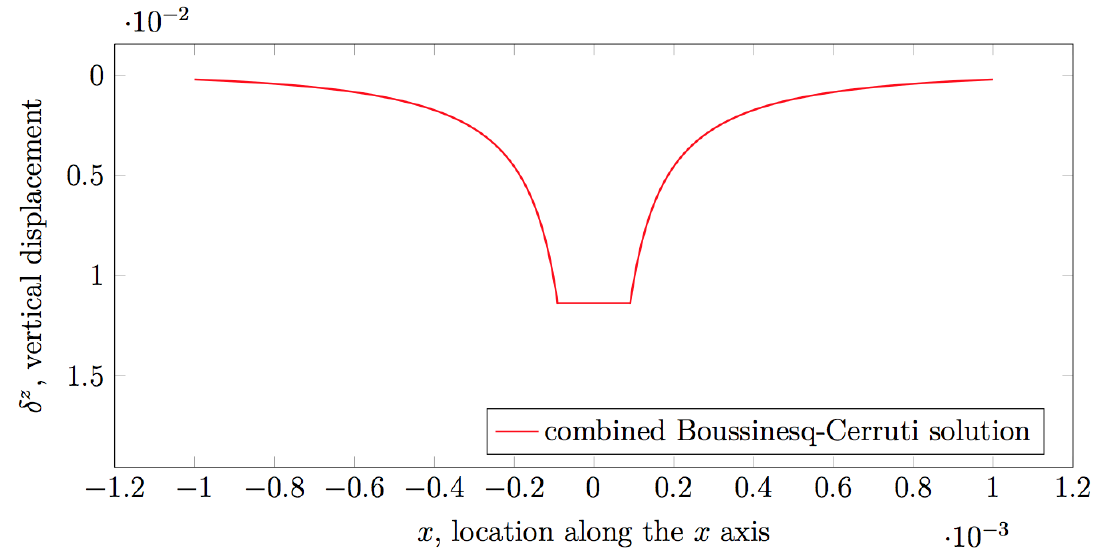
Figure 3. Continuous solution for the Boussinesq–Cerruti singularity